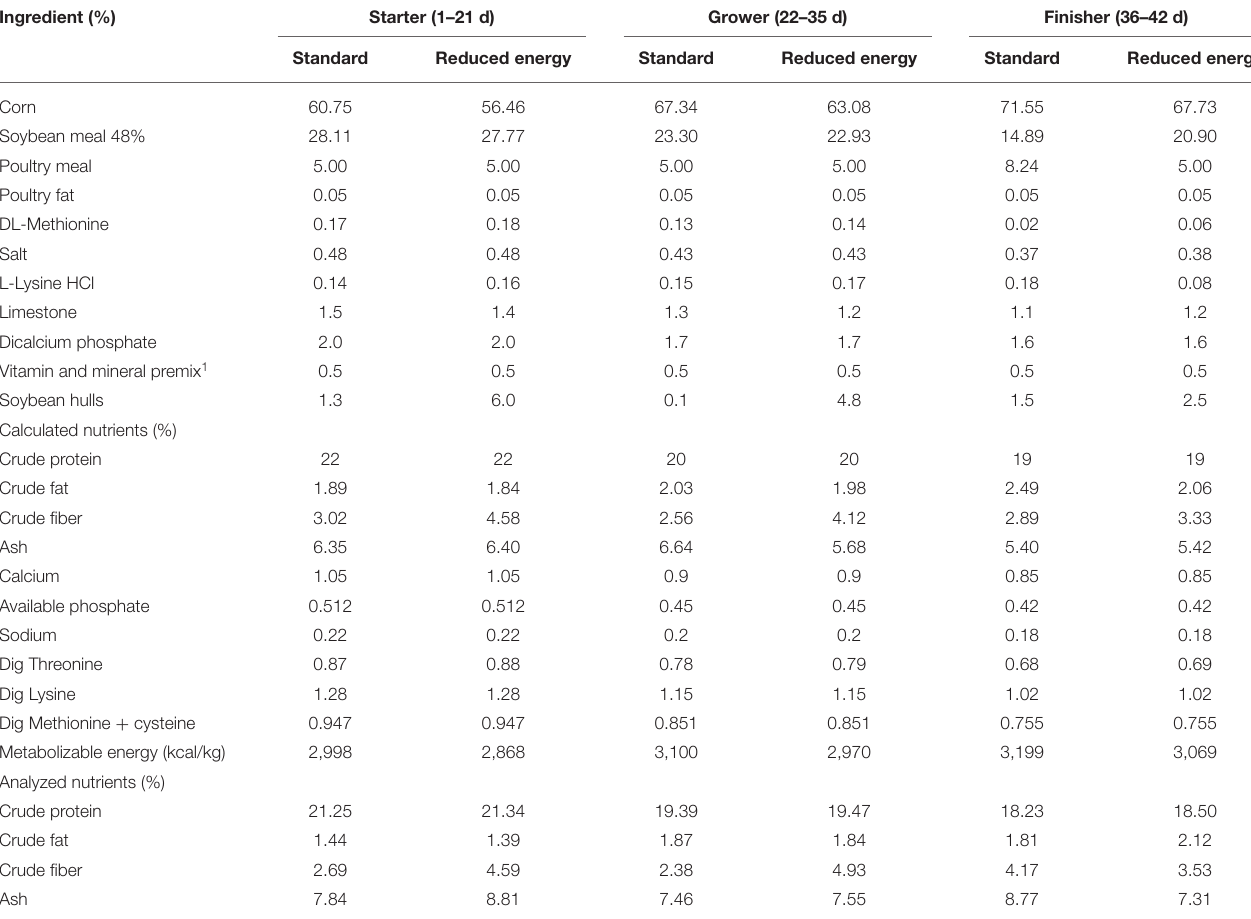
TABLE 1 | Composition and nutrient content of experimental diets. Ingredient (%)